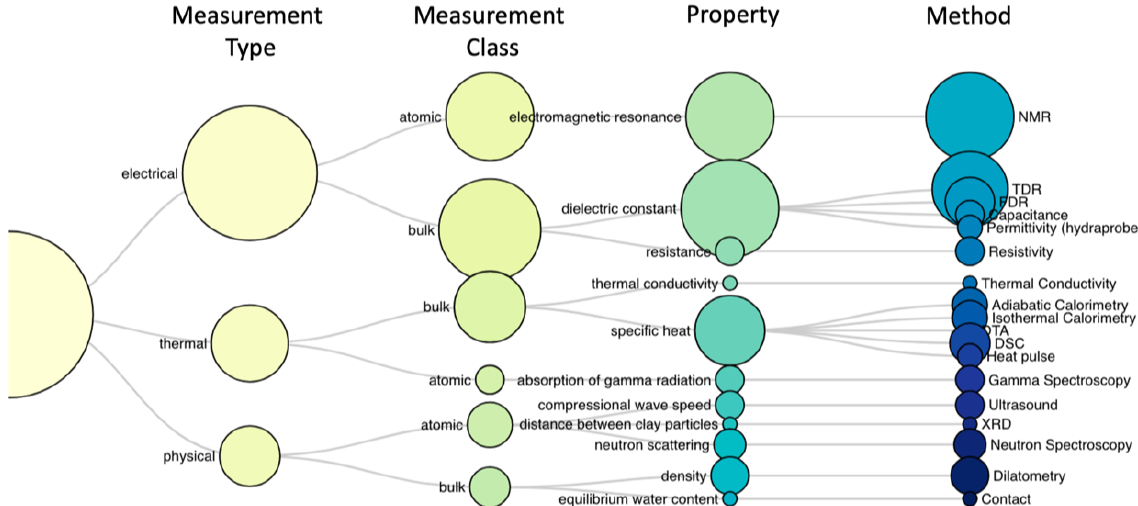
Figure 2. Organization of measurement methods according to measurement principle. The size of nodes represents the relative number of SFCCs collected using each method.